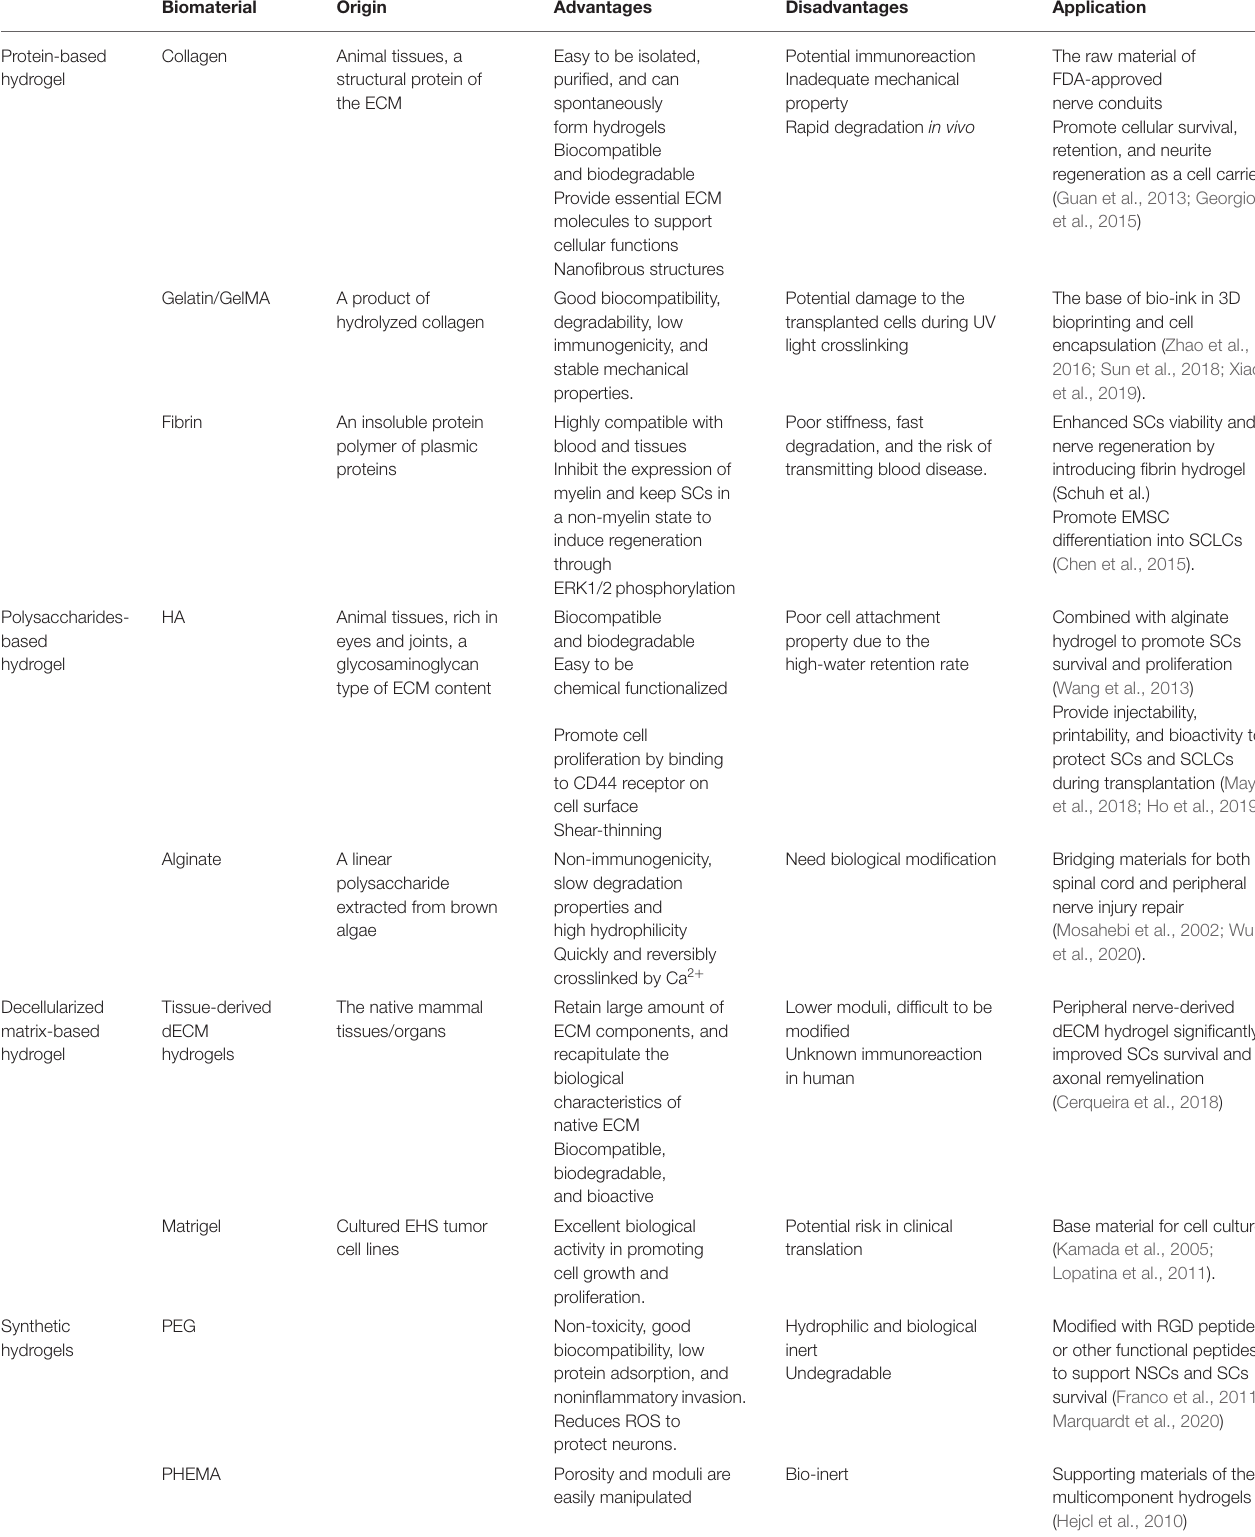
TABLE 1 | Hydrogels used for SCs/SCLCs